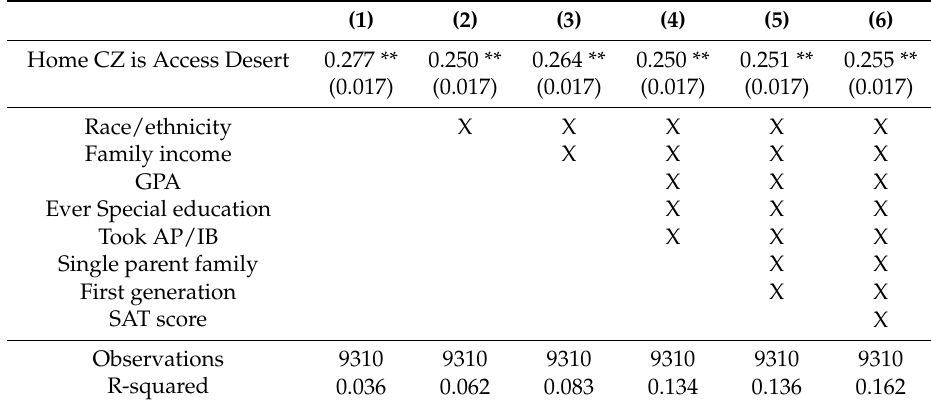
Table 4. Relationship between living in an access desert and enrolling in a college outside of home commuting